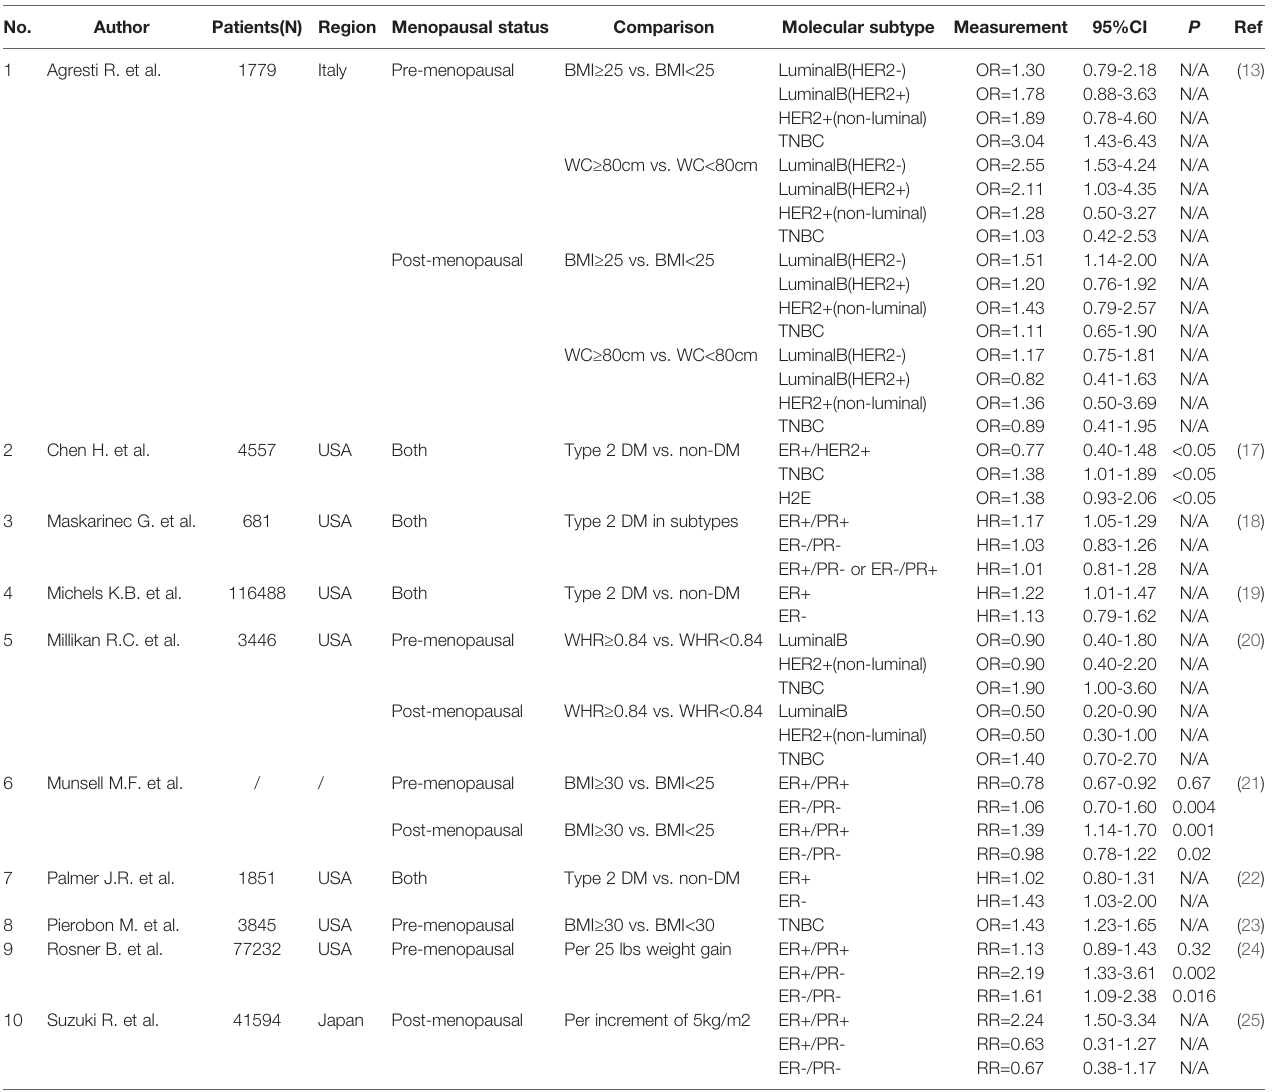
TABLE 1 | Obesity and its measurement indexes with the risk of different breast cancer